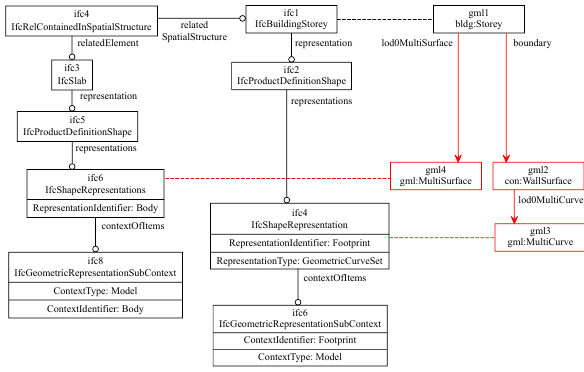
Figure 7. Population of CityGML storeys from IFC